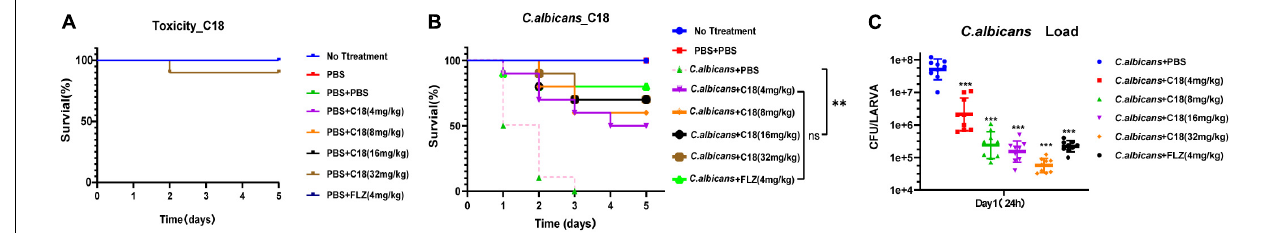
FIGURE 4 | In vivo toxicity and therapeutic activity of C18 in a Galleria mellonella model. (A) The toxicity of C18 in G. mellonella larvae model. A range of concentrations (4 mg/kg ∼ 32 mg/kg) of C18 injected to the larvae (10 µ l pre larva) was applied to evaluate toxicity of the peptide. Only 10% of the larvae died when treated with 32 mg/kg C18 for 5 days. (B) Survival assays for 3 replicate experiments combined ( n = 30). Galleria mellonella larvae were infected with 10 µ l inoculum of 5 × 10 7 CFU/ml of Candida albicans and treated with various concentrations of C18 or 4 mg/kg FLZ. For each replicate, a group of 10 larvae in each treatment was monitored for survival over 5 days. ** p < 0.01, compared to the group of C. albicans + phosphate buffer solution (PBS). (C) Fungal burden for three replicate experiments ( n = 3). For each replicate, three larvae from each group were sacrificed at 24 h post treatment, homogenized, cultivated on yeast extract peptone